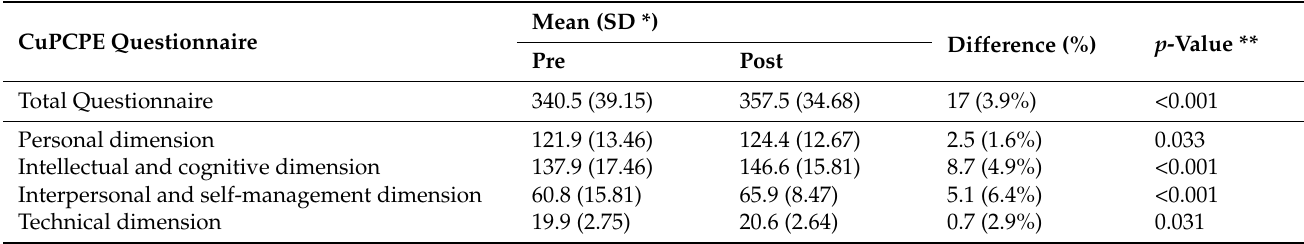
Table 2. Average scores for CuPCPE questionnaire pre- and post-simulation (mean (SD)) and differ- ence between measurements (% of the maximum score) ( n = 61).